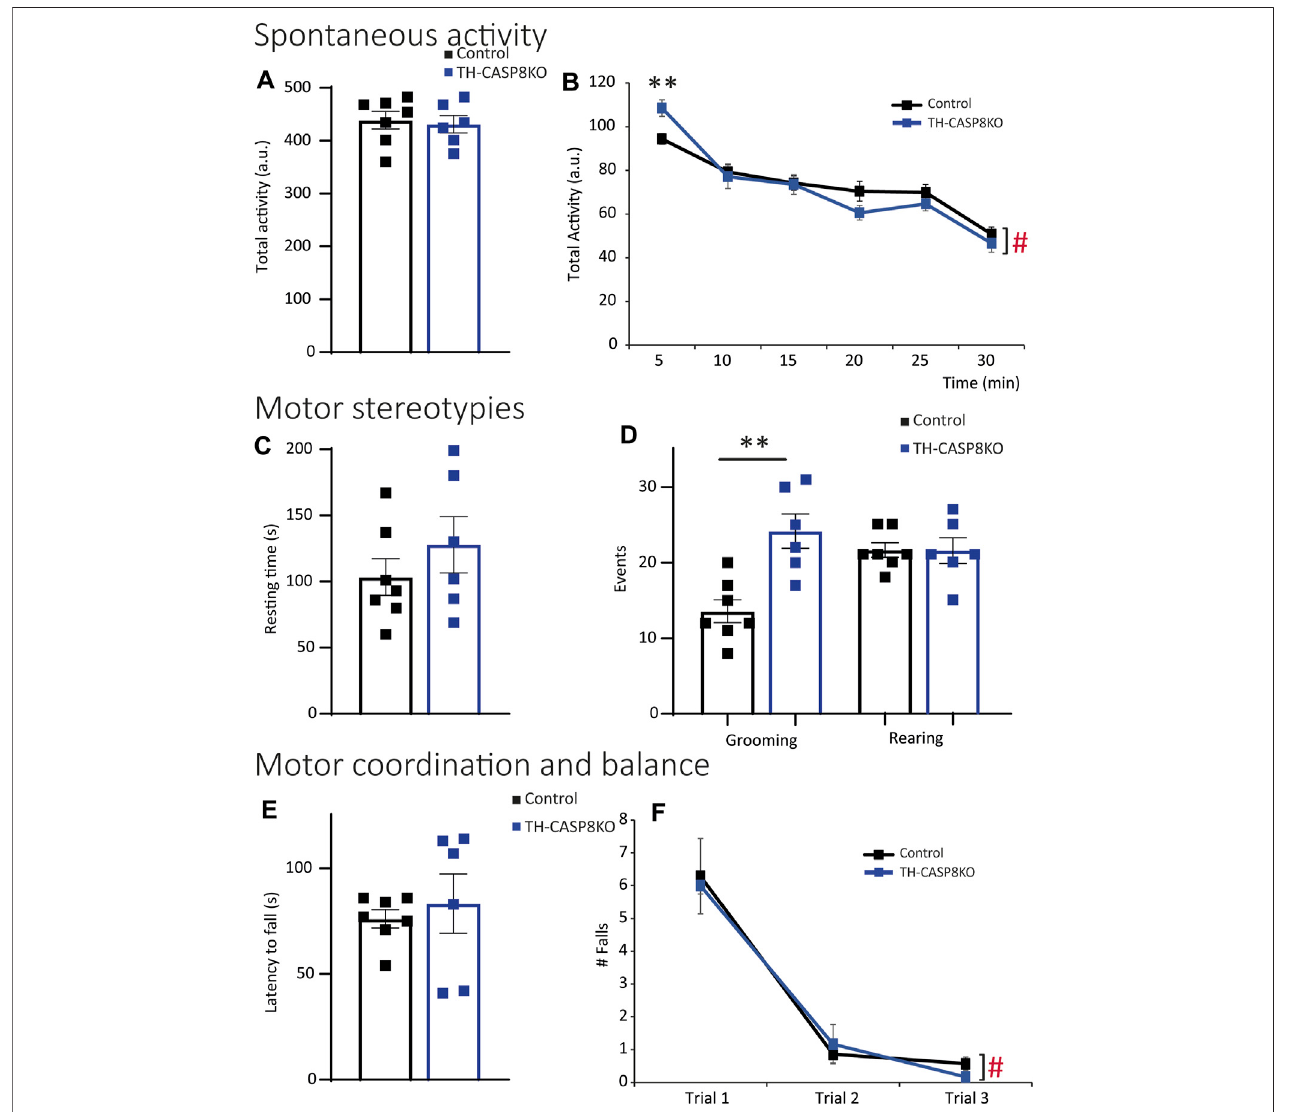
FIGURE5| TH-CASP8KO micearehyperlocomotive inthefaceofnovelcontext andexhibitrepetitive andperseverantbehaviors. (A,B) TH-CASP8KO miceshow similar activity for 30 min (total activity; (A) ) and for each time bin except for the fi rst 5 min (every 5 min; (B) ) in the open fi eld test. TH-CASP8KO mice show the same restingtime duringtheopen fi eldsession (C) ,however,spendingmoretimegroomingbutnotrearingthancontrolanimals (D) .Theirrotarod performanceiscomparable to the control group, in both the accelerated rotarod (4 – 40 rpm; (E) ) and the constant velocity rotarod (5 rpm; (F) ). Data are expressed as mean ± SEM of n = 6 – 7 mice/group. The two-tailed unpaired t test was used (A,C – E) . ** (Control vs . TH-CASP8KO), p < 0.01; # (Control and TH-CASP8KO 5 min vs. Control and TH- CASP8KO 30 min), p < 0.001 versus control mice. One-way analysis of variance (ANOVA) followed by Bonferroni post hoc for multiple comparisons (B,F) was used. a. u.: arbitrary